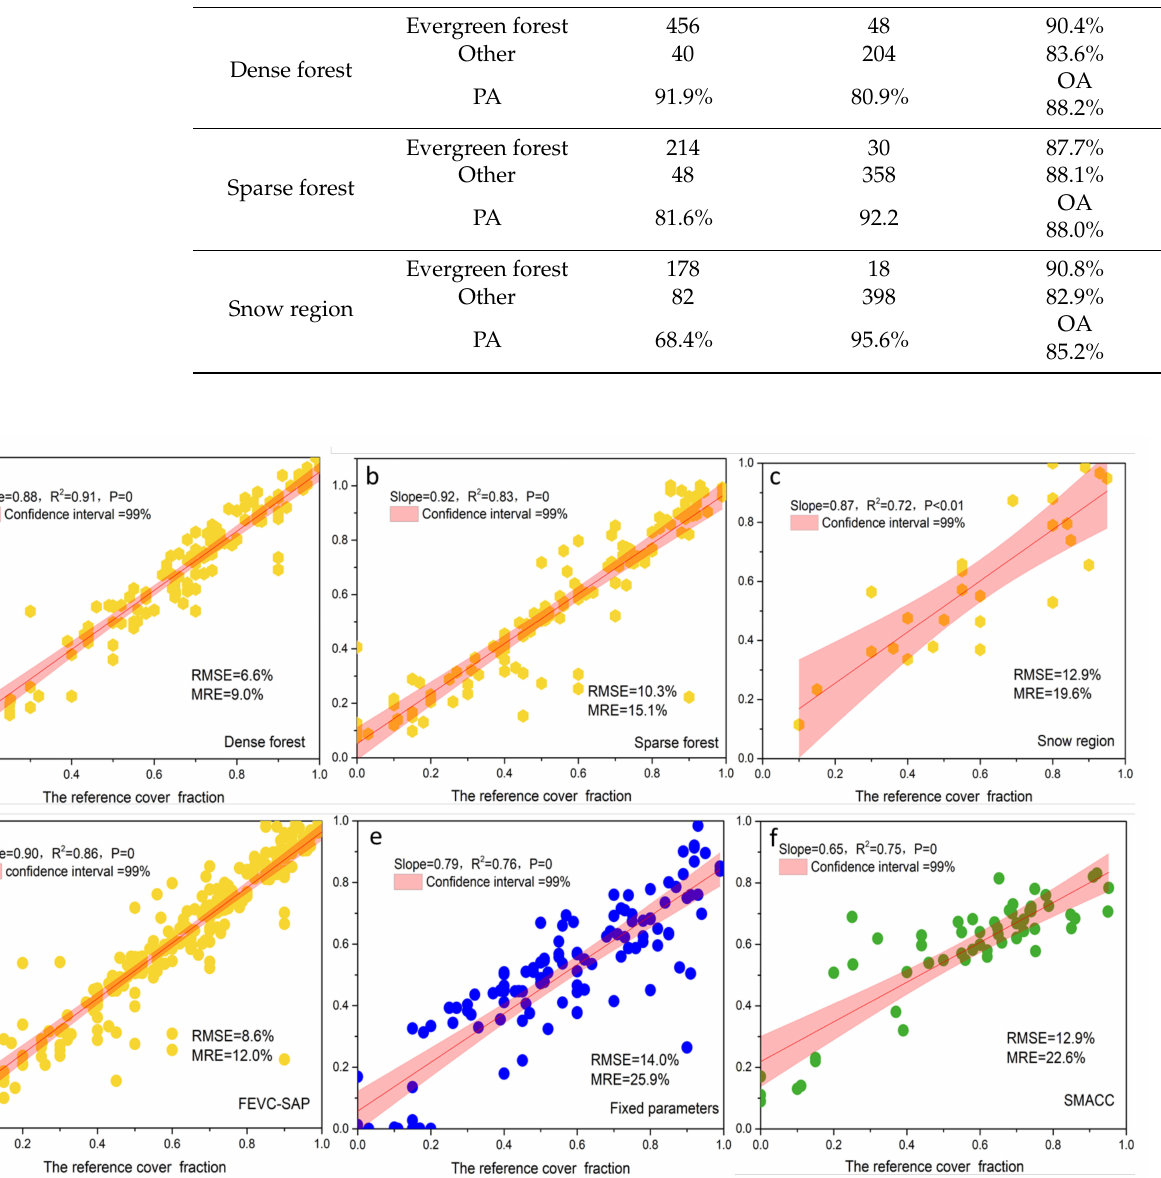
Figure 8. Predicted and reference evergreen forest cover values for regions dominated by three types of land cover, obtained using the fixed-parameter method and SMACC methods. ( a – c are accuracy comparisons in different regions and d – f are accuracy comparisons of different